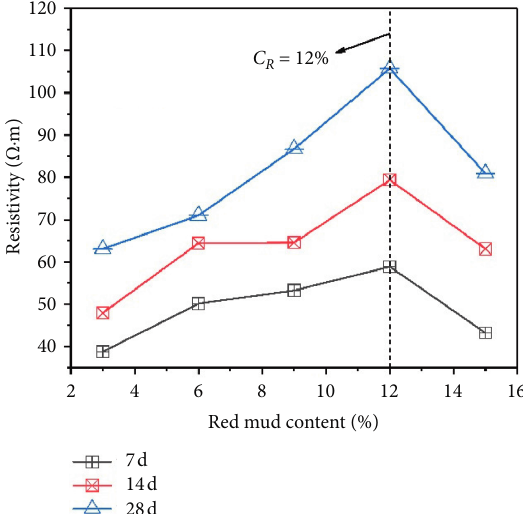
Figure 6: The relationship between resistivity and red mud content under different curing time